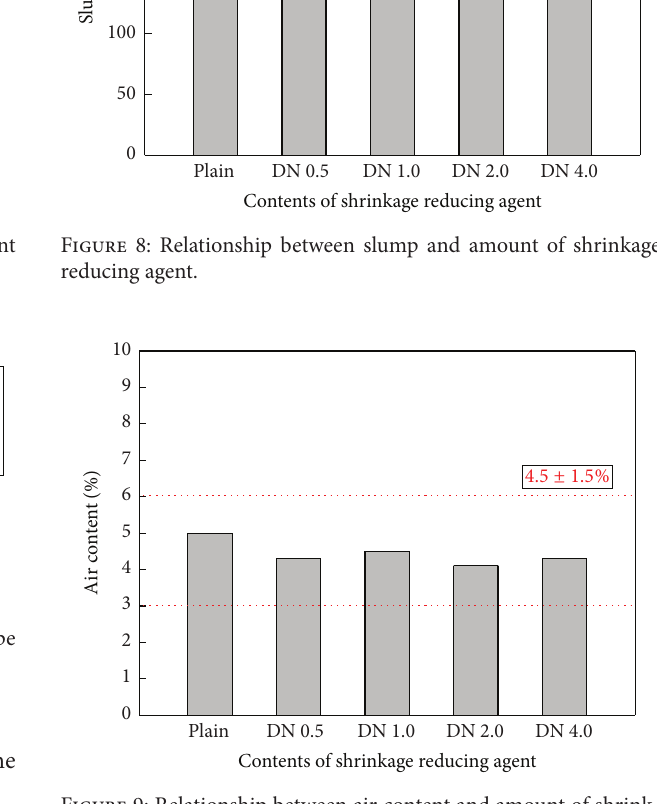
Figure 9: Relationship between air content and amount of shrink- age reducing